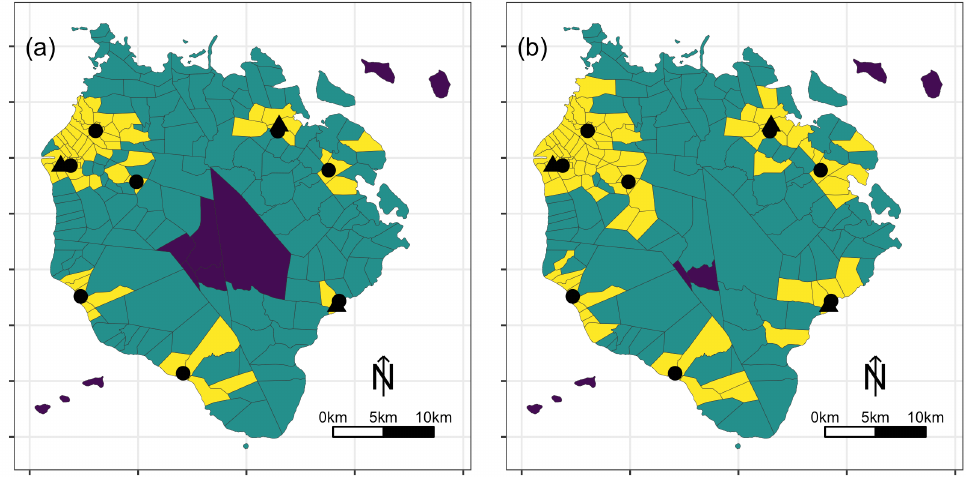
Figure 5. Minimum village distance travel to the nearest healthcare facility in Marinduque, Philippines.